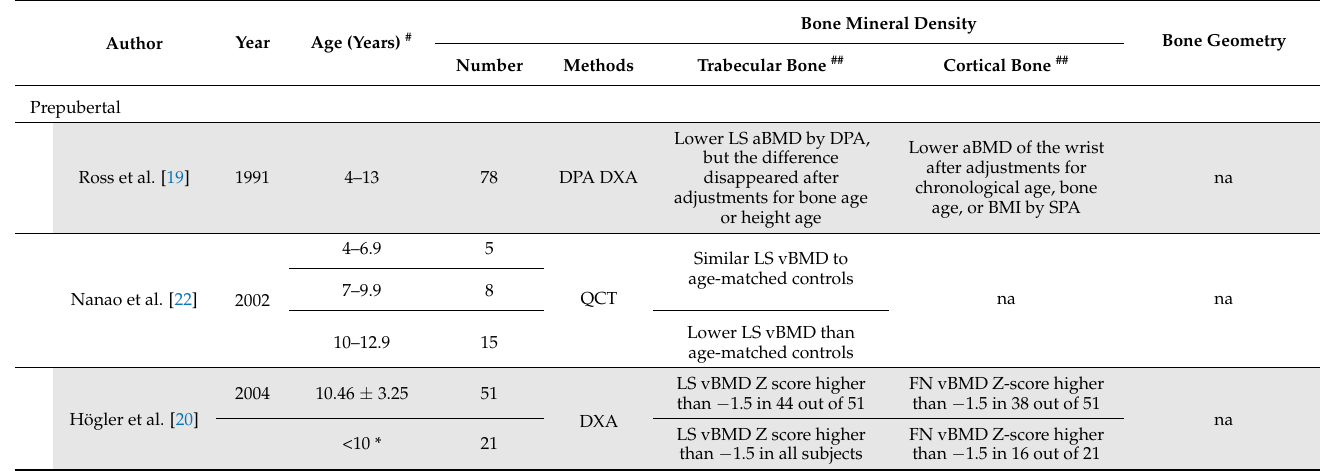
Table 1. Bone mineral density and geometry in children and adolescents with Turner